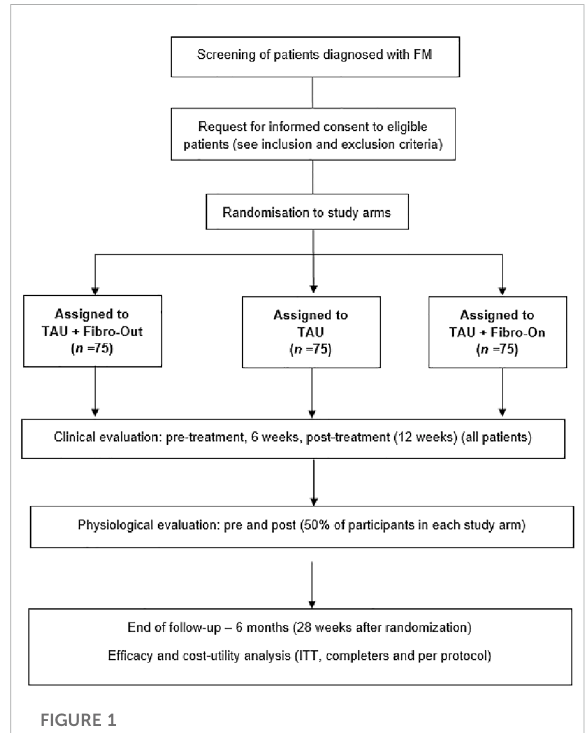
FIGURE 1 Flowchart of the On&Out study based on the Consolidated Standards of Reporting Trials guidelines. Fibro-Out, FIBROWALK Outdoors; Fibro-On, FIBROWALK Online; ITT, intention-to-treat; TAU,